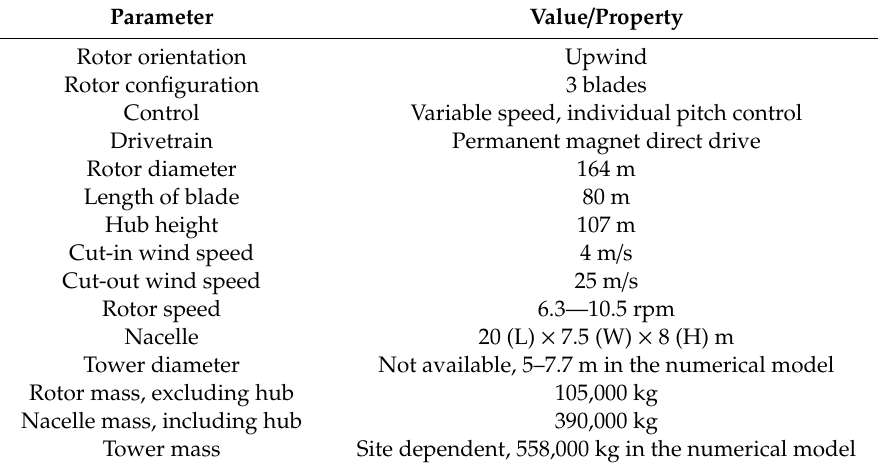
Table 2. Parameters of offshore wind turbine modelled V164-8.0.